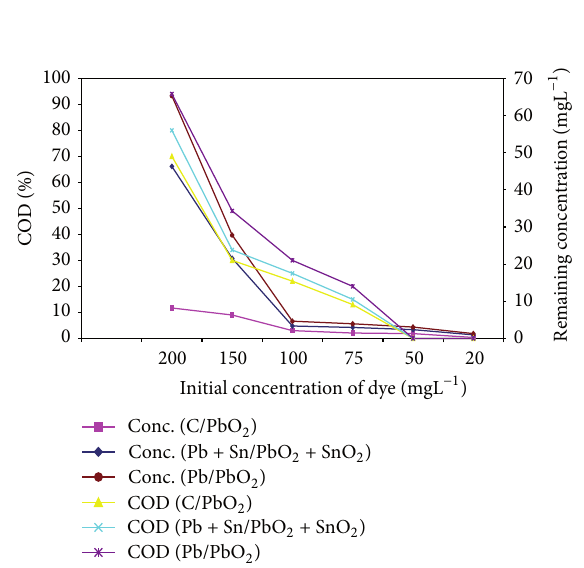
F 6: e effect of initial concentration on RY160 and COD removal using C/PbO